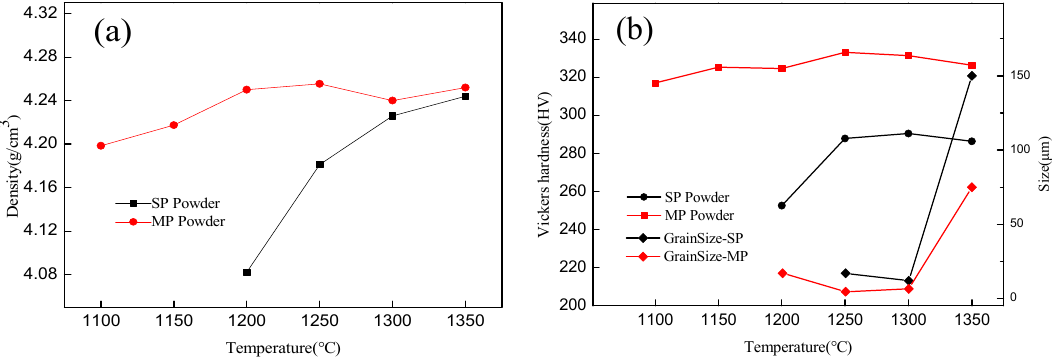
Figure 4. Density, Vickers hardness and average grain size of Ti-48Al-2Cr-8Nb alloy as a function of sintering temperature. ( a ) Density and ( b ) Vickers hardness and average grain size (densation greater than 97%).